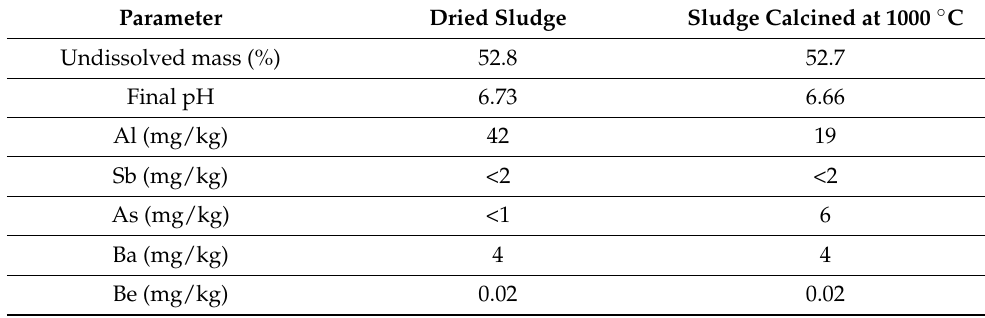
Table 7. Results of the ammonium citrate